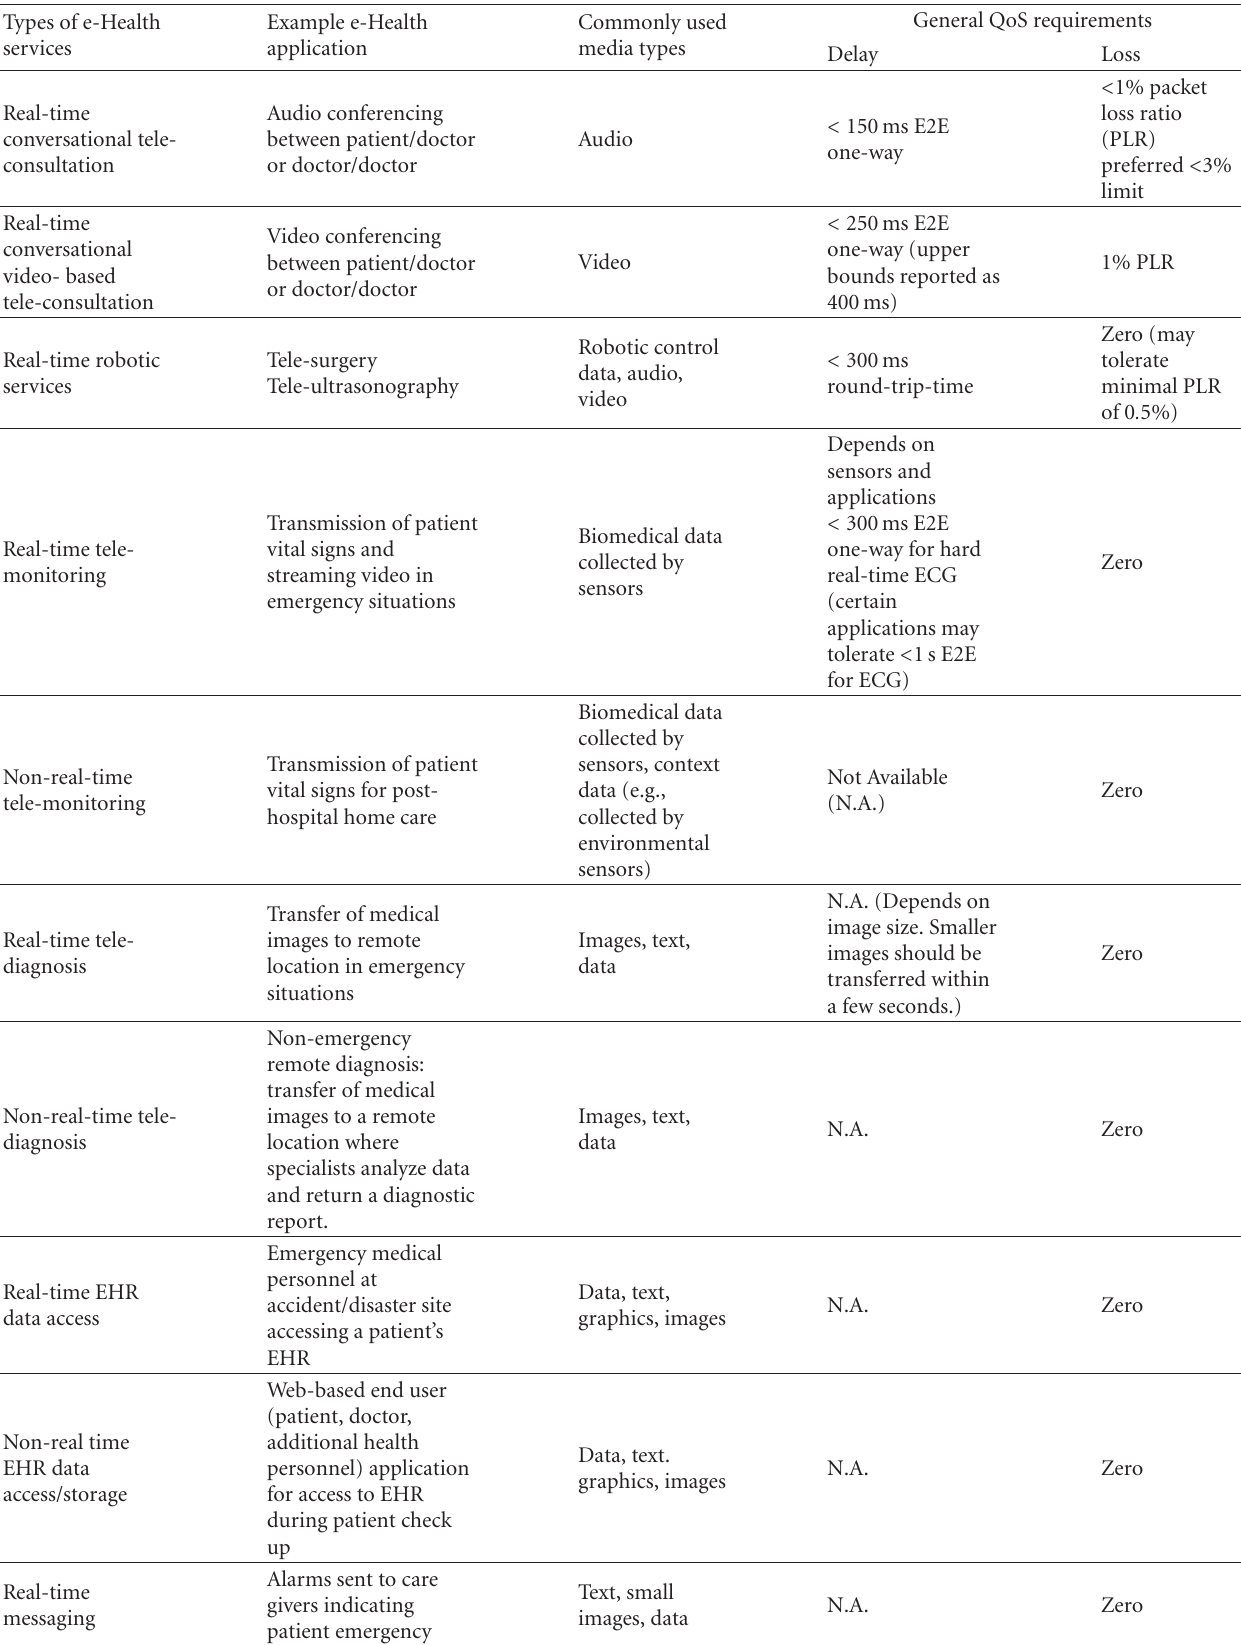
Table 4: Summary of QoS requirements for e-Health